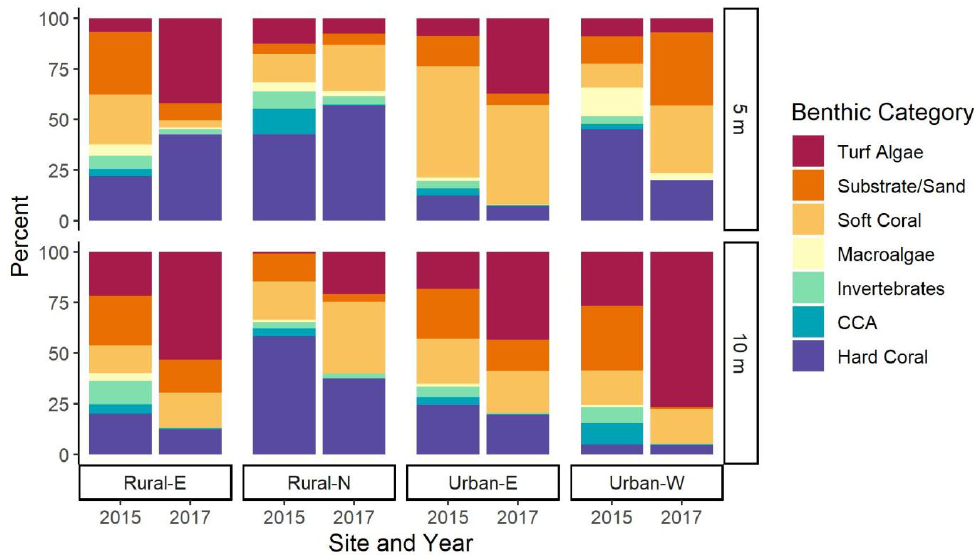
Figure 3. Benthic composition cover from 15 m line intercept transects by site (Rural-N, Rural-E, Urban-W, Urban-E) and depth (5 and 10 m) for November 2015 and June 2017 surveys in Timor- Leste. Major categories include: Hard Coral; CCA — crustose coralline algae; Invertebrates — mobile invertebrates; Macroalgae; Soft Coral; Substrate/Sand; and Turf algae. Coral community composition, as measured by the abundance of individual coral genera from belt transects, also differed significantly by a site and depth interaction [three- way repeated measures PERMANOVA pseudo- F (3,47) = 3.2546, p (perm) = 0.0001]. Hard coral diversity, calculated using the Shannon diversity index of hard coral genera counted measures ANOVA χ 2 (3) = 16.1668, p = 0.0010]. Urban-W had the lowest coral diversity of all sites at 10 m but had comparable diversity at 5 m depth (Shannon index 1.7 ± 0.2; 18 ± 2 genera) (Figure S2). The maximum genus richness of 33 ± 2 was present at Rural-N with consistently high (>40%) coral cover in both survey years. This site also had significantly more tabulate [three-way repeated measures ANOVA χ 2 (3) = 31.5895, p < 0.0001] at both depths than all other sites with 21.1 ± 0.7 colonies per transect ( p < 0.05). Remaining sites averaged less than five acroporid colonies per transect. There was a significant three-way interaction between site, depth, and year for branching acroporids [three-way repeated measures ANOVA χ 2 (1) = 7.8254, p = 0.0498]. Branching Acroporids decreased at all sites and depths between survey years except for Rural-N and Urban-W at 10 m (Figure S3). Although 51 genera were found across the belt transects over all four sites, only a few genera dominated the reef, namely Porites (2015 = 17.4%, 2017 = 13.0%), Fungia (2015 = 13.7%, 2017 = 19.0%), and Montipora (2015 = 12.9%, 2017 = 13.4%). Community composition measured from belt transects was also significantly differ- ent with a year and site interaction [pseudo- F (3,47) = 2.1713, p (perm) = 0.0002]. Urban-E was the only site with comparable coral community between years, and all sites were sig- nificantly different within years [ p (perm) < 0.05]. In Figure 4, sites were generally distrib- uted along axis two of the PCoA with Rural-N most positively associated with tabulate acroporids, Galaxea , Goniopora , Montipora , and Stylophora , while differences between depth were aligned along axis one with more Pocillopora , Platygyra , and massive Porites corals on the 5 m transects. Dispersion, or variability in community composition was also